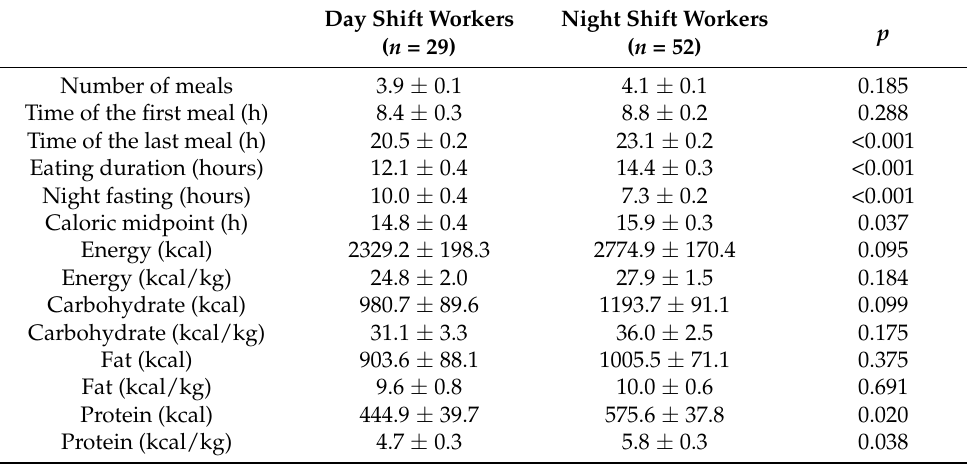
Data represented as mean ± standard error of the mean (SEM). Generalized Estimated Equations (GEE) were used to compare the time-related patterns and food consumption between day and night shift workers, adjusted for age and BMI. p -values < 0.05 were accepted as